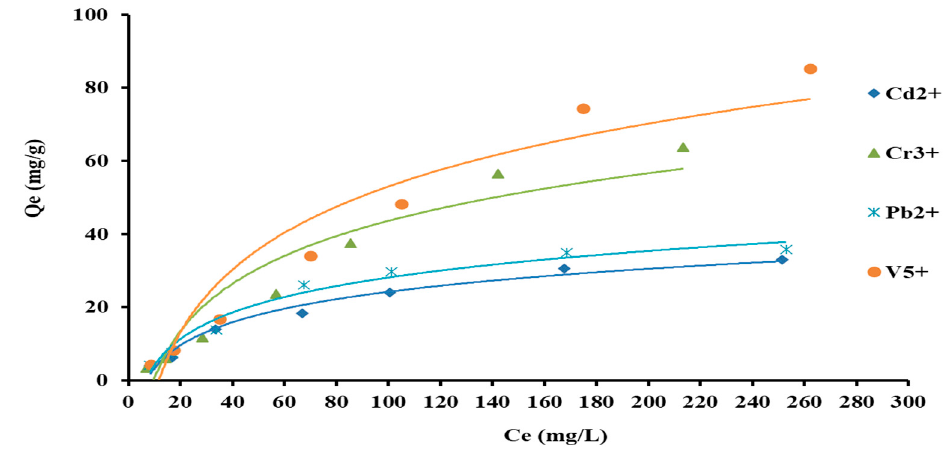
Figure 9. Equilibrium adsorption capacity versus the initial